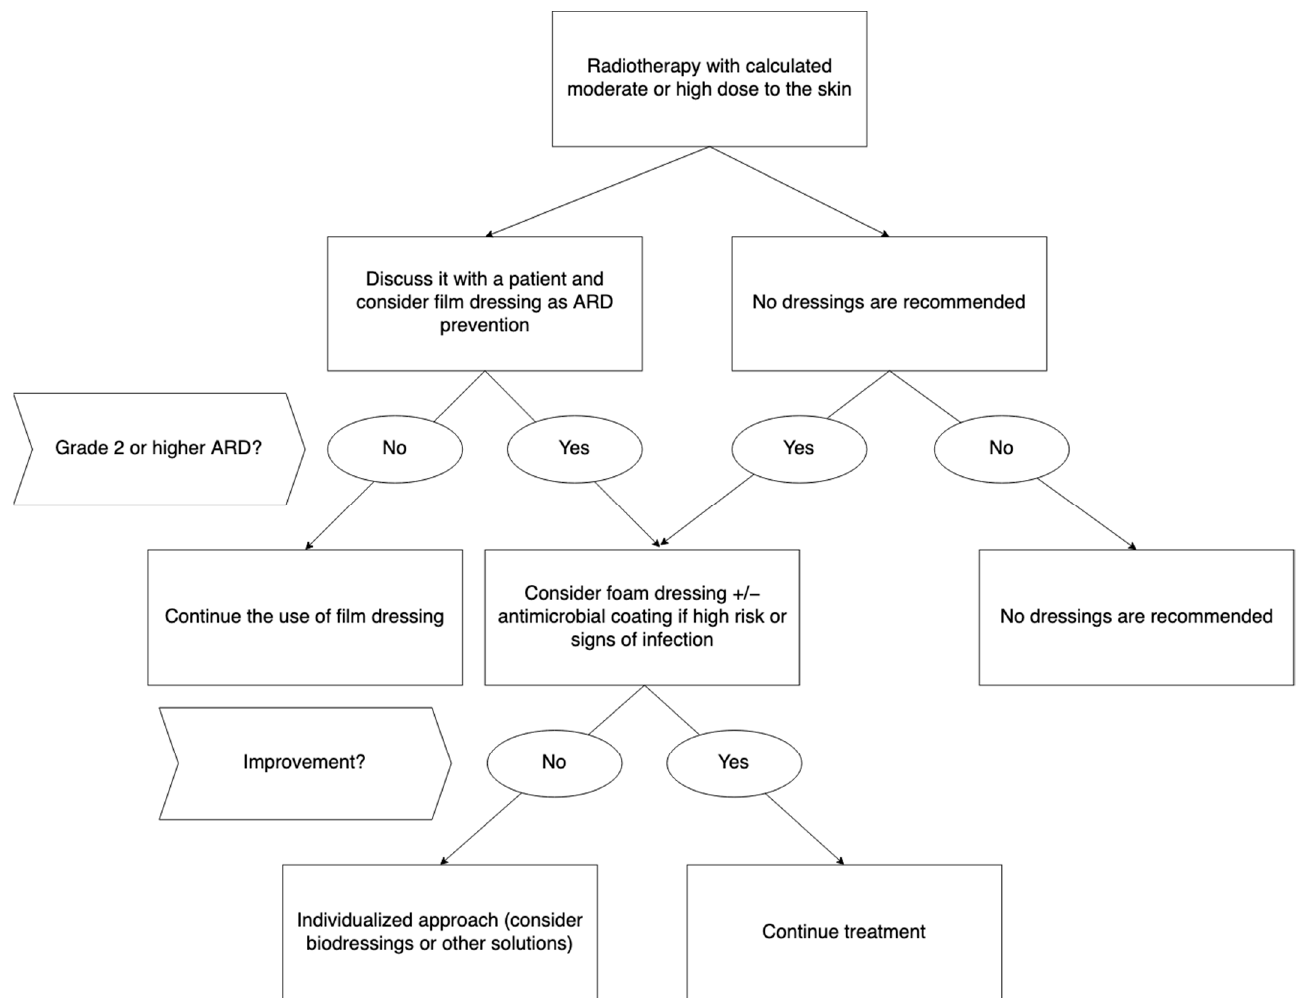
Figure 3. Recommended dressings for prevention and treatment of acute radiation dermatitis. Abbreviations: ARD—acute radiation dermatitis.